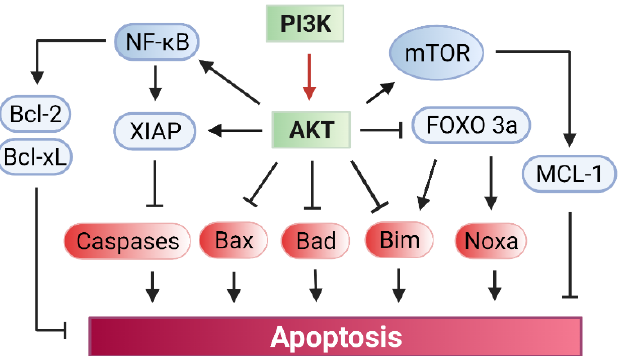
Figure 4. PI3K/AKT mediated signaling promotes cell survival. (i) Activation of PI3K by radiation leads to the phosphorylation/activation of AKT; (ii) AKT phosphorylates and inhibits the pro-apoptotic proteins Bad, Bax, and Bim; (iii) AKT activates Nuclear factor (NF)- κ B transcription factor, resulting in the up-regulation of the expression of pro-survival genes Bcl-2 and Bcl-xL; (iv) AKT phosphorylates the pro-survival protein XIAP, which binds to and inhibits caspase3/7/9 that are required for apoptosis induction; (v) AKT phosphorylates/activates the mammalian target of rapamycin (mTOR) kinase, which then phosphorylates and activates the anti-apoptotic protein Mcl-1; (vi) phosphorylation of Forkhead box O (FOXO)3a (transcription factor) by AKT results in the inhibition and nuclei exclusion of FOXO3a, which otherwise up-regulates the gene expression of pro-apoptotic proteins Bim and Noxa.